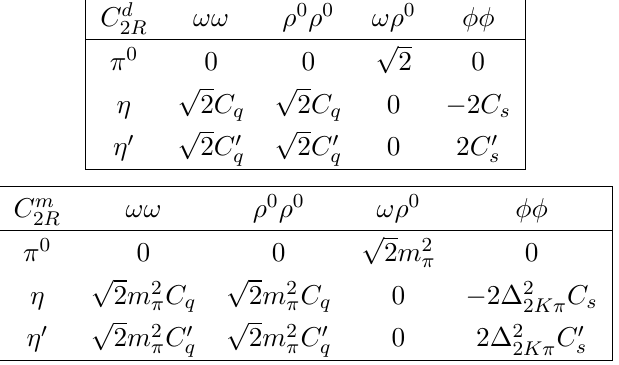
Table 6 . Values of C m